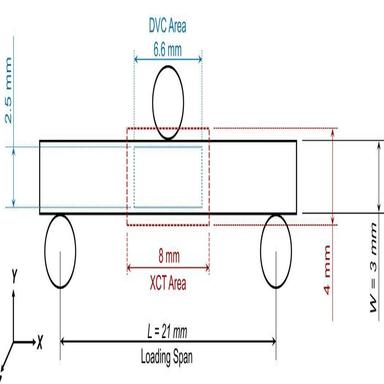
Two-dimensional diagram of the three-point bending set-up and regions of tomographic acquisition and DVC analyses; Note: W is the in-plane width and B is the outof-plane thickness of the specimen. The loading span (L)/ width (W) ratio is 7.